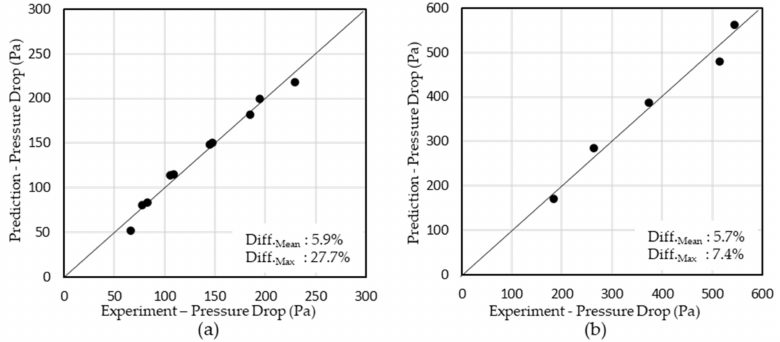
Figure 10. Di ff erence comparison of experimental and numerical results of pressure drop across the plate-fin heat exchanger ( a ) plain; ( b ) o ff set